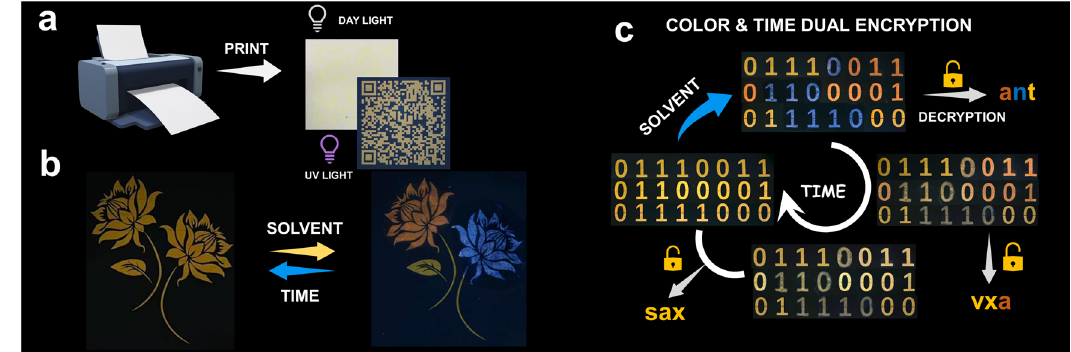
Fig. 6 Security features of fl uorescent ink. a Schematic representations for the printing experiment and a photograph of the printing pattern 2D code decrypted under UV light. b Fluorescence images of the printing pattern before and after treatment with organic solvent (blue) and water (orange). The fl uorescence change was reversible and transient, reverting back to yellow with time. c Fluorescent photographs of the printing binary code, illustrating colour and time dual encryption